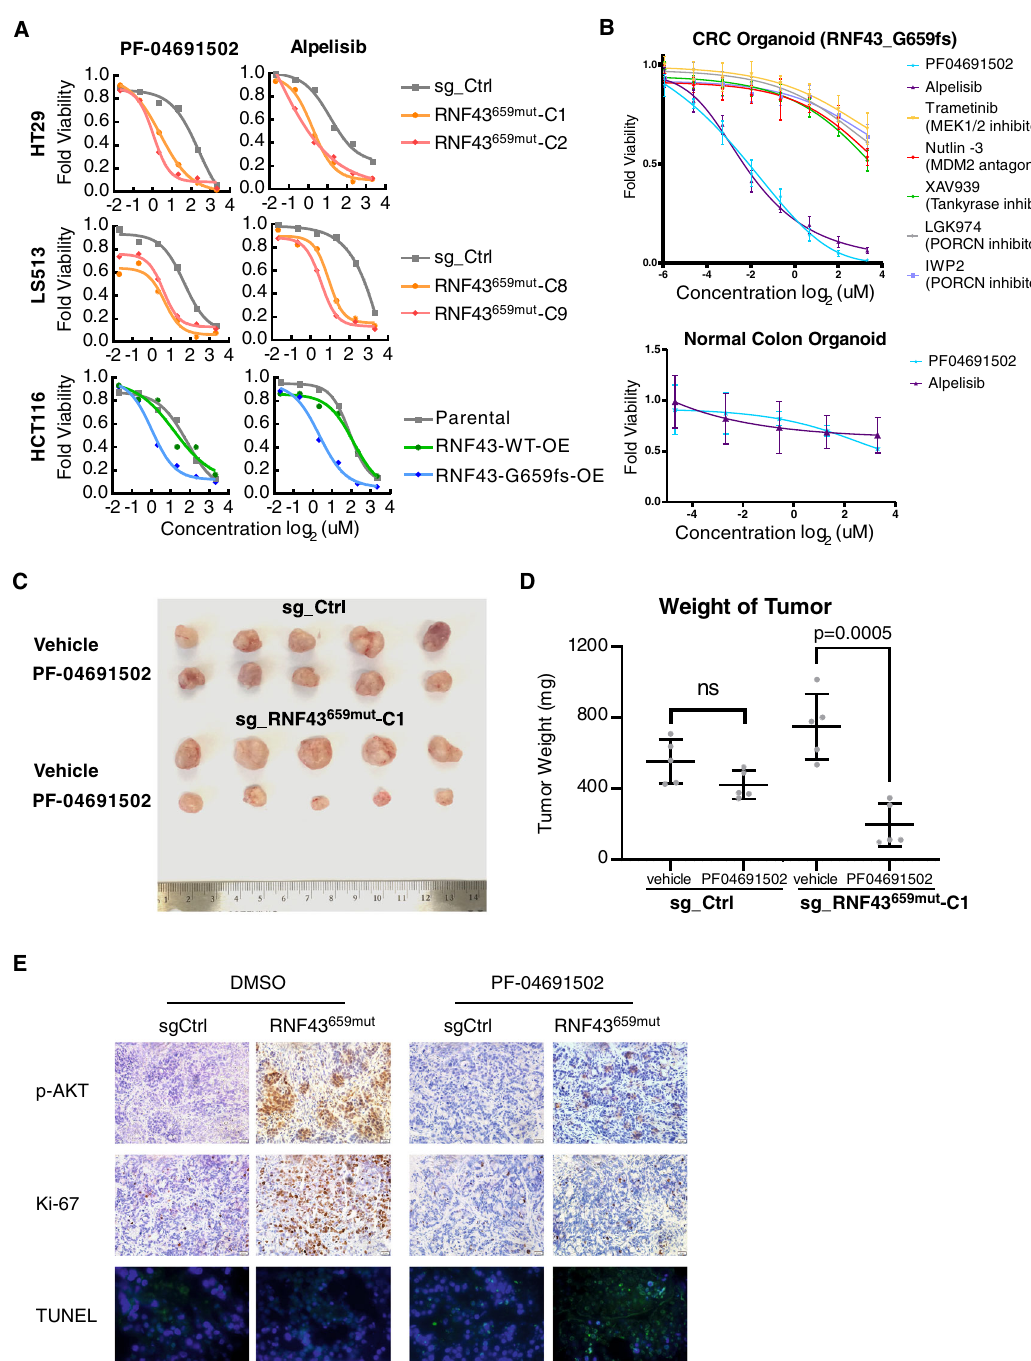
Fig. 3 Assessment of PI3K/mTOR compound ef fi cacy in CRC RNF43 _659fs preclinical models. A Alpelisib and PF-04691502 dose-response curves